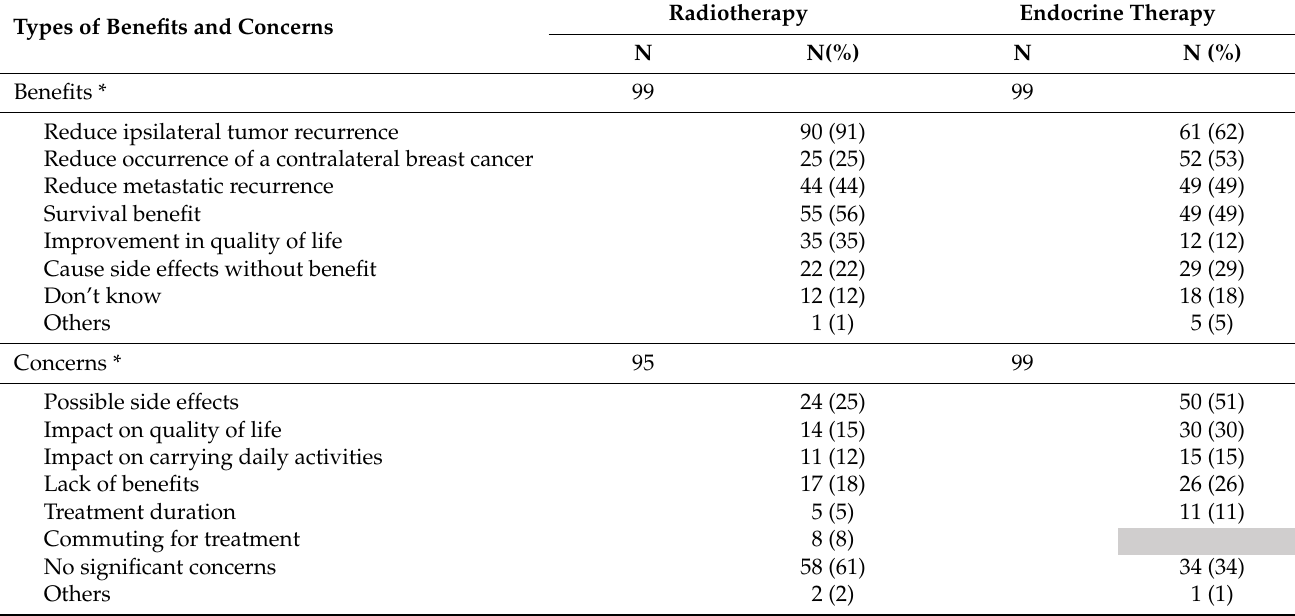
Table 2. Perception of radiotherapy and endocrine